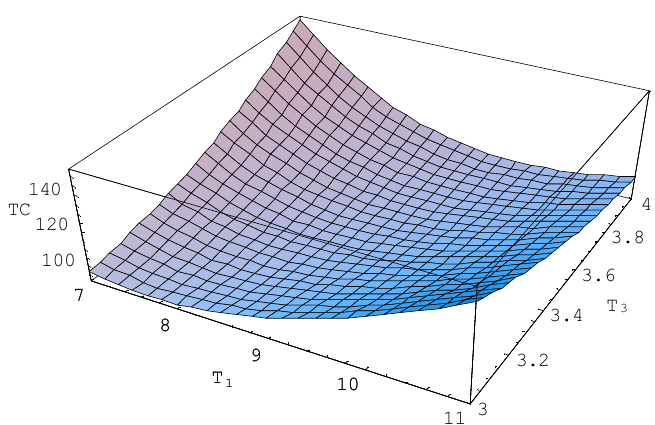
Fig. 3. The Producer and Supplier’s unit time total cost in crisp